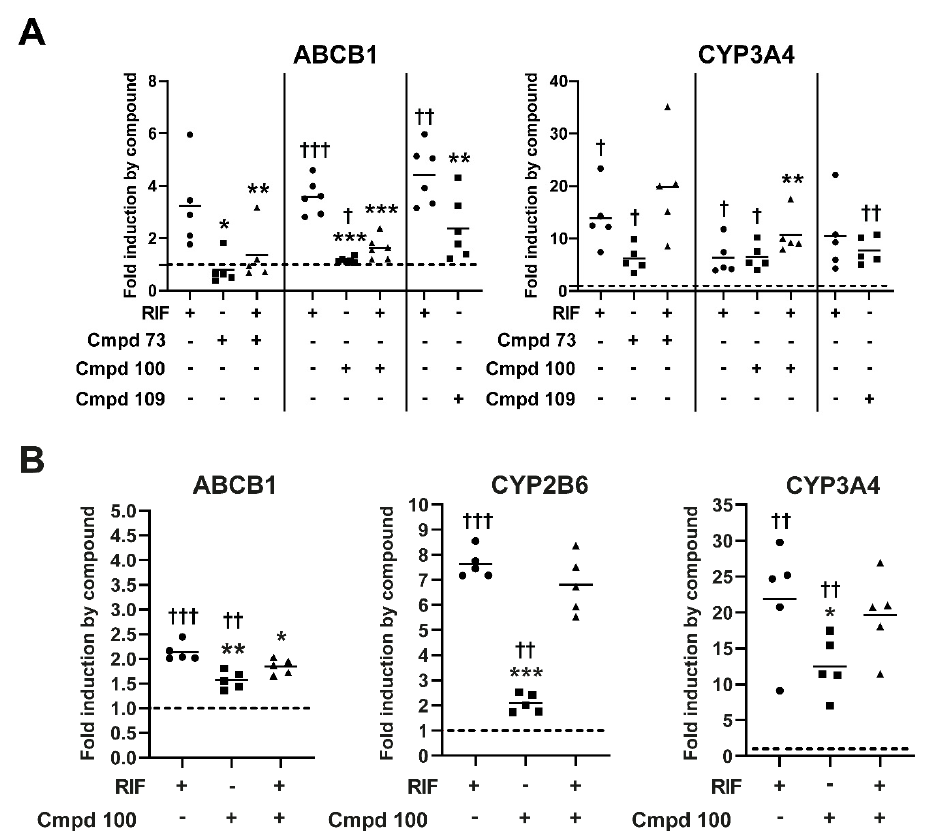
Figure 7. Effects of novel PXR ligands on endogenous PXR target gene expression. ( A ) LS174T cells were treated with 0.1–0.2% DMSO, 10 µ M rifampicin (RIF), or 10 µ M test compounds or